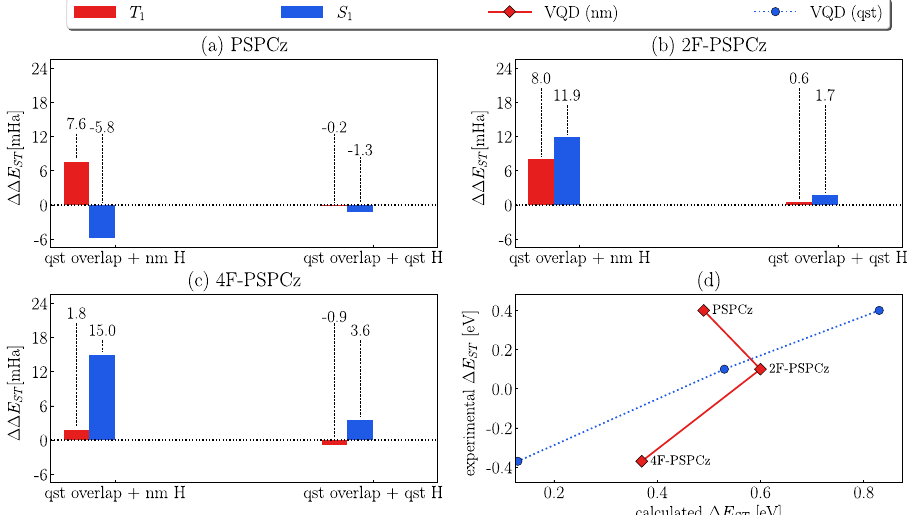
Fig. 6 Electronic energies of ground and excited states of PSPCz molecules, in mHa, by VQD on ibmq_singapore , and correlations of predicted and experimental energy gaps, in eV. Energies of the T 1 and S 1 excited states (shown in red and blue, respectively) of ( a ) PSPCz, ( b ) 2F-PSPCz, and ( c ) 4F-PSPCz obtained from VQD calculations on ibmq_singapore in comparison to predictions by exact diagonalization. d Correlations between Δ E ST from spectral experiments and VQD calculations with the R y Ansatz on ibmq_singapore using the 6-31G(d) basis set. (nm non-mitigated; qst quantum state tomography; H: